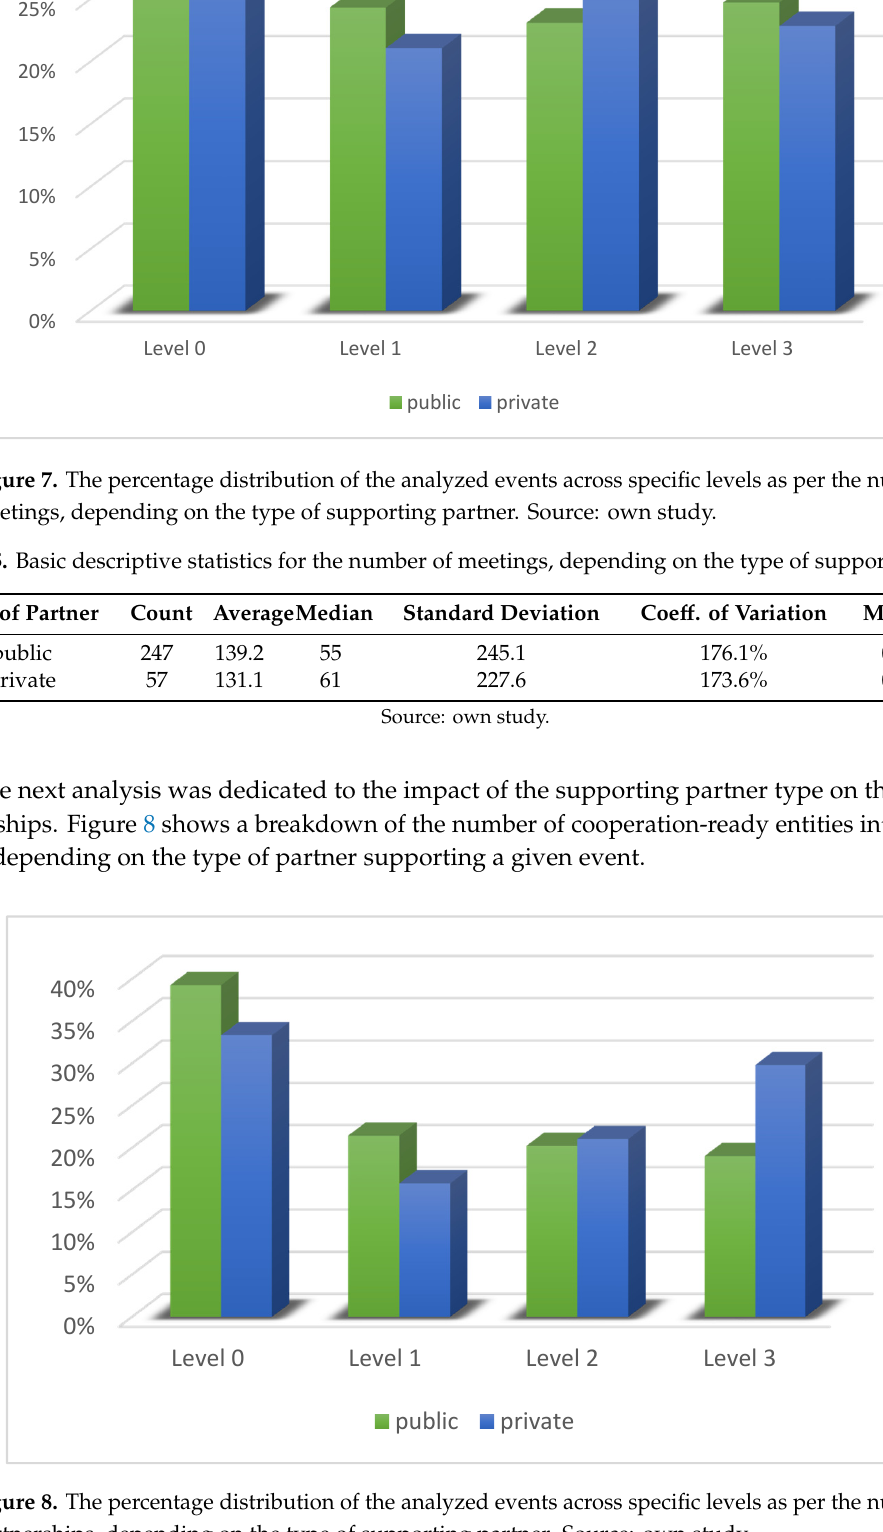
Figure 8. The percentage distribution of the analyzed events across specific levels as per the number of partnerships, depending on the type of supporting partner. Source: own study.